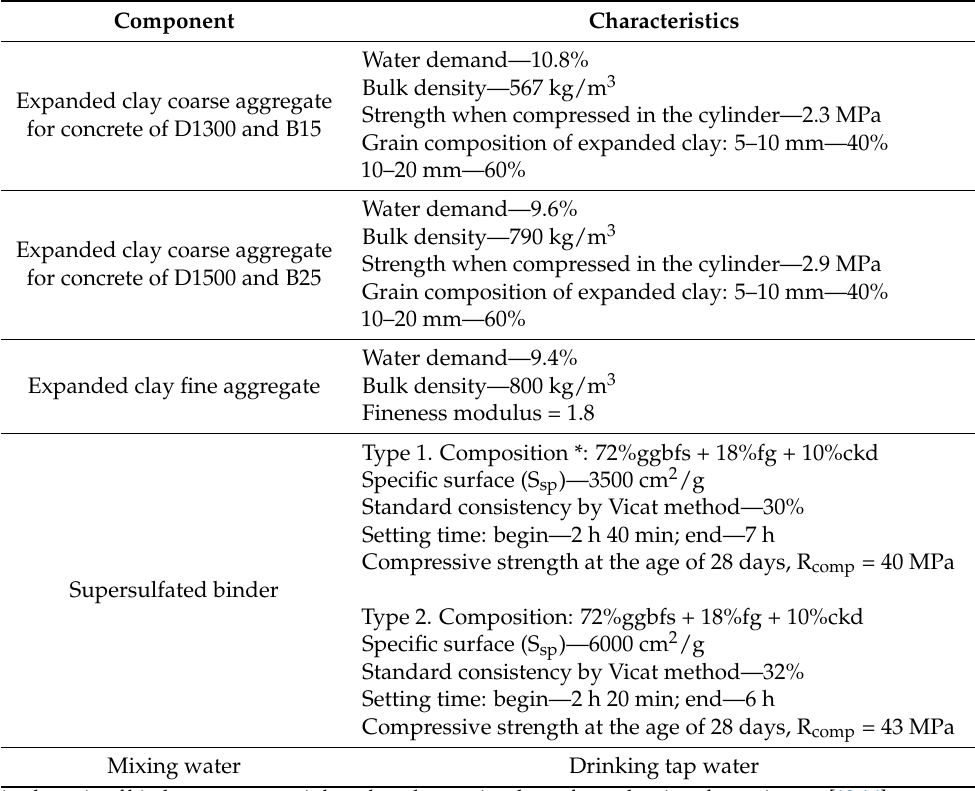
Table 5. Characterization of lightweight concrete